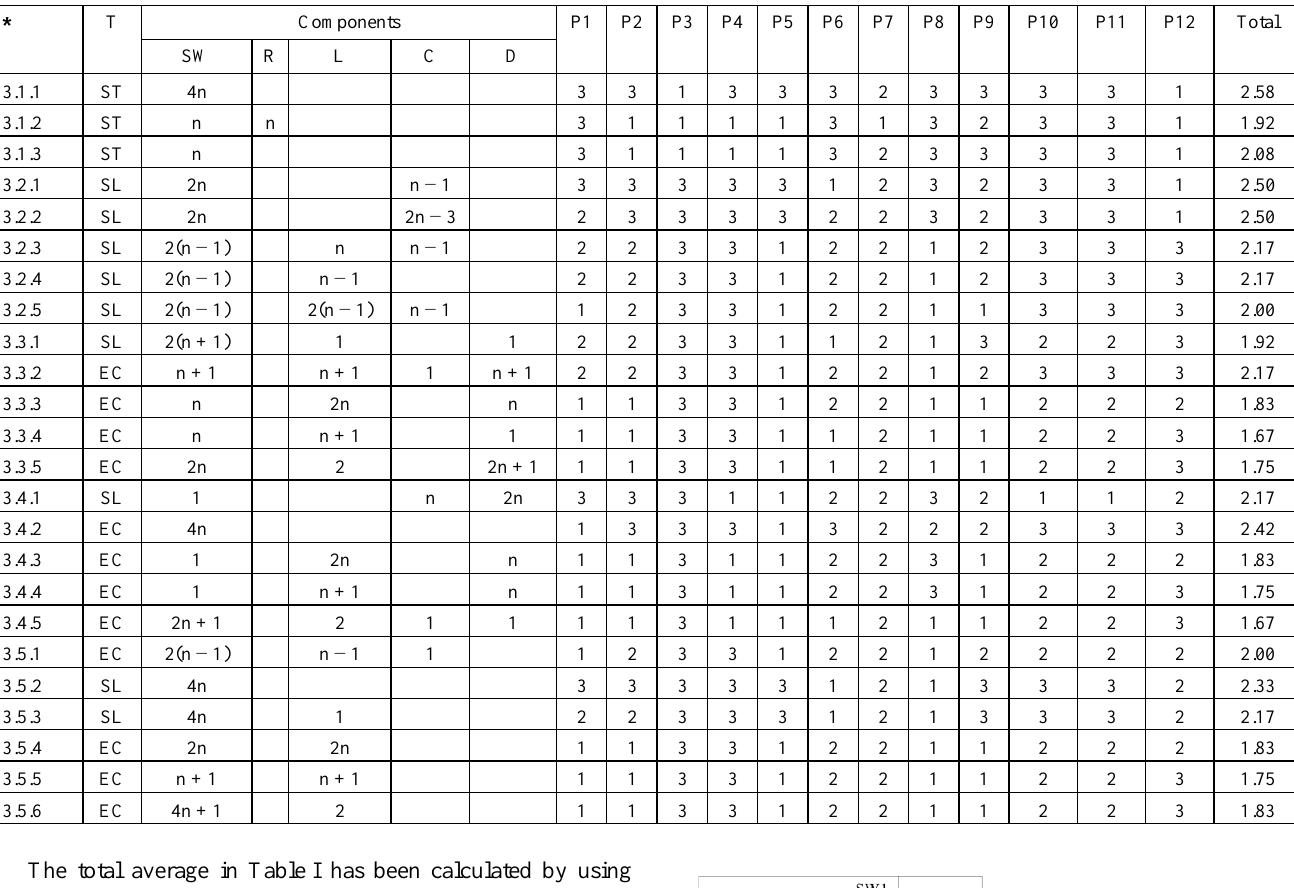
C LASSIFICATION OF A CTIVE B ALANCING M ETHODS